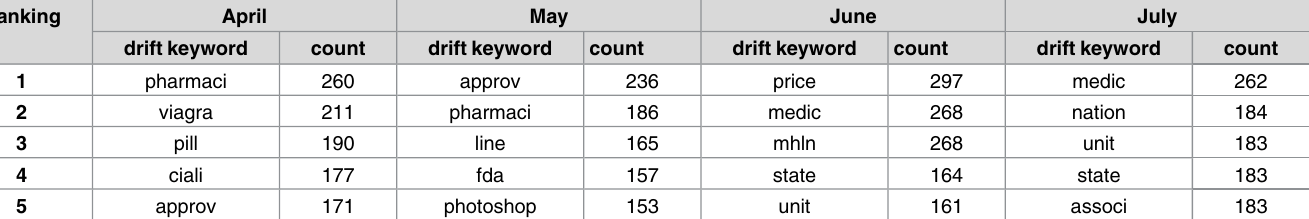
Table 6. Top five keyword counts by